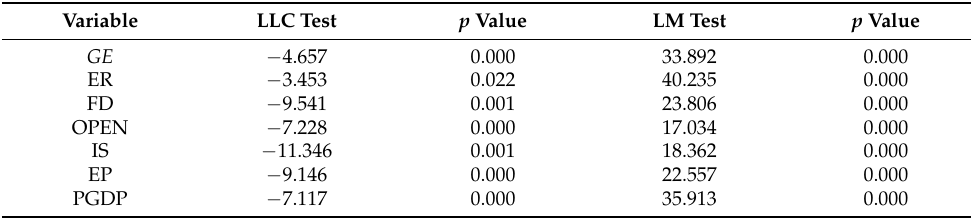
Table 4. Unit root test.